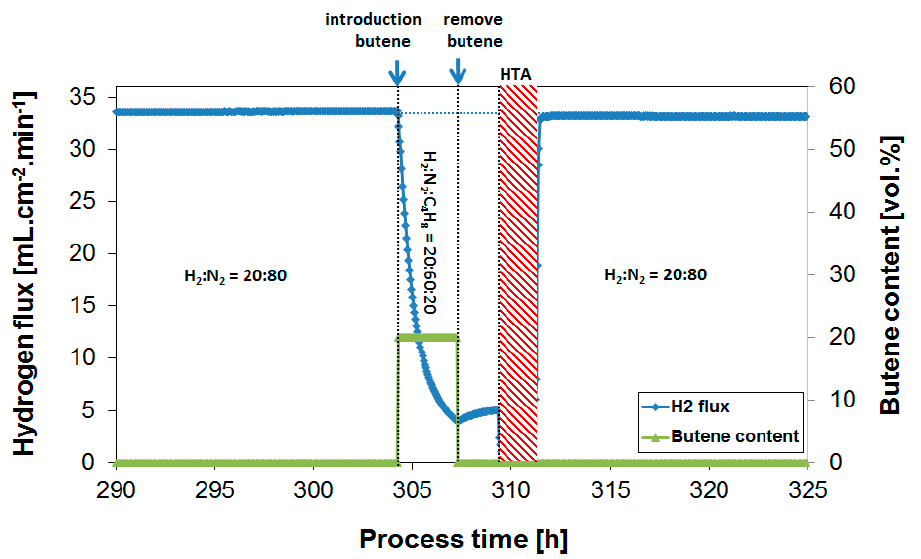
Figure 4. H 2 flux during butylene exposure (20%) to a feed mixture of H 2 :N 2 :C 4 H 10 = 20:60:20, and subsequent air treatment to regenerate the membrane performance. Temperature = 400 °C.